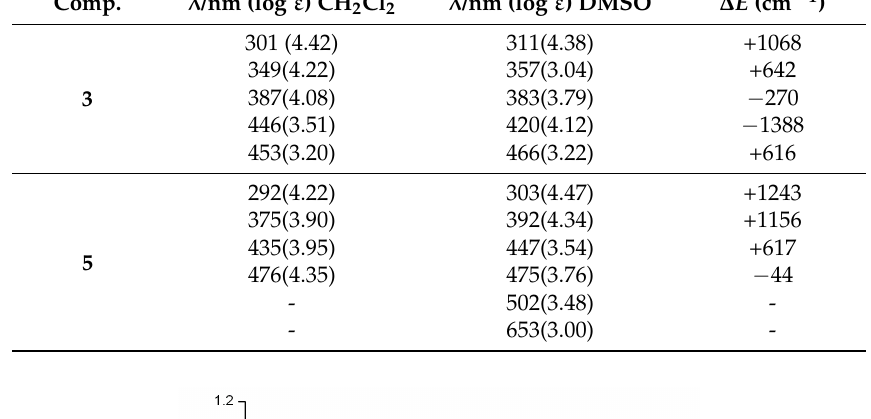
Table 3. Deconvoluted UV-Vis absorption data for complexes 3 and 5 . Comp.